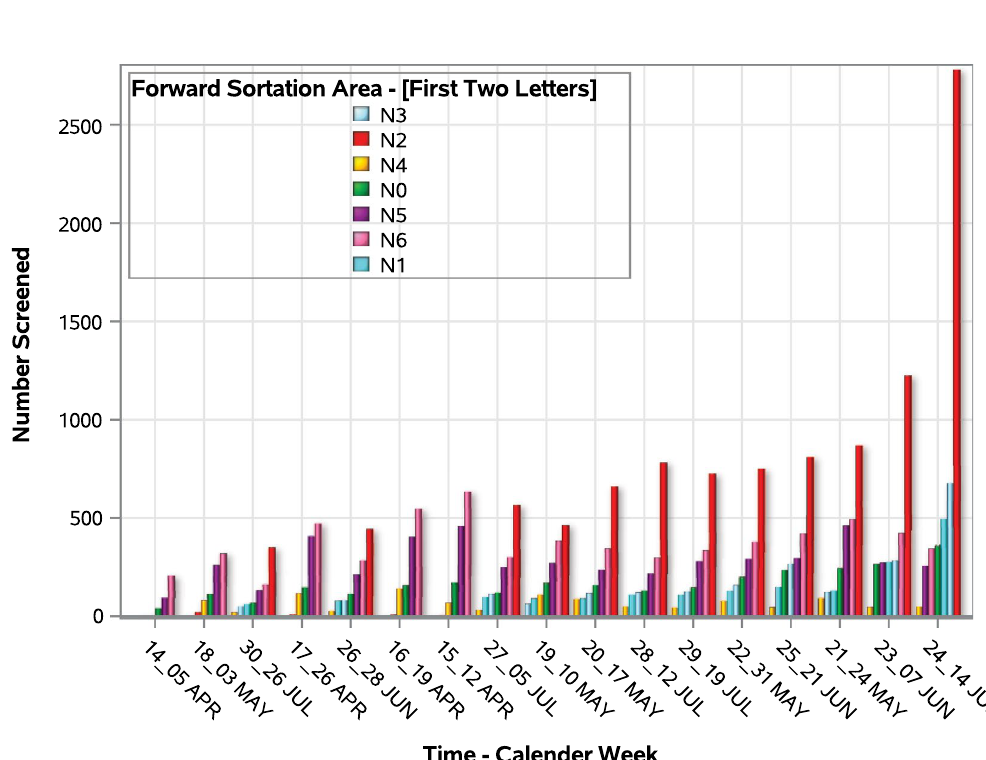
Figure 6. Trend in the number of self-assessments on the portal by postal